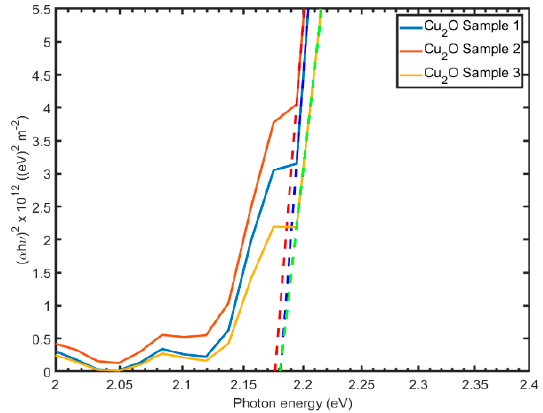
Figure 8. Percentage ( a ) reflectance, ( b ) absorptance, and ( c ) transmittance as a function of wavelength for the metal oxide structure.